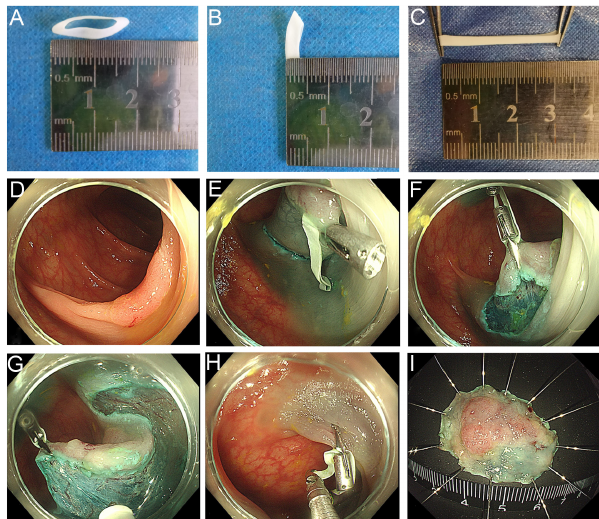
Figure 1. A case of inner traction-facilitated endoscopic submucosal dissection (ESD) using rubber band and clip (RAC-ESD). (A, B) Rubber bands made of latex glove